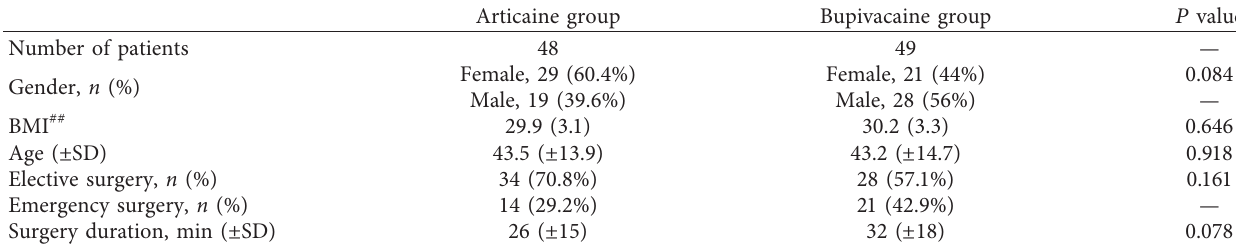
Figure 3: Consort diagram. Table 1: Patient demographics.